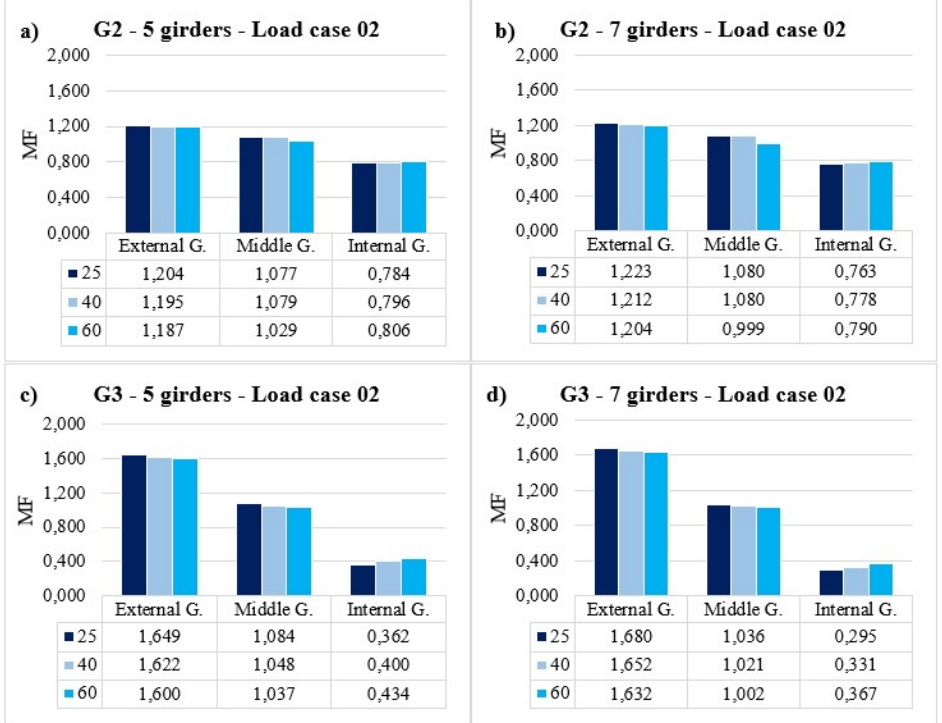
Figure 18. Modifications Factors for load case 02: (a) 5L-G2; (b) 7L-G2; (c) 5L-G3; (d)